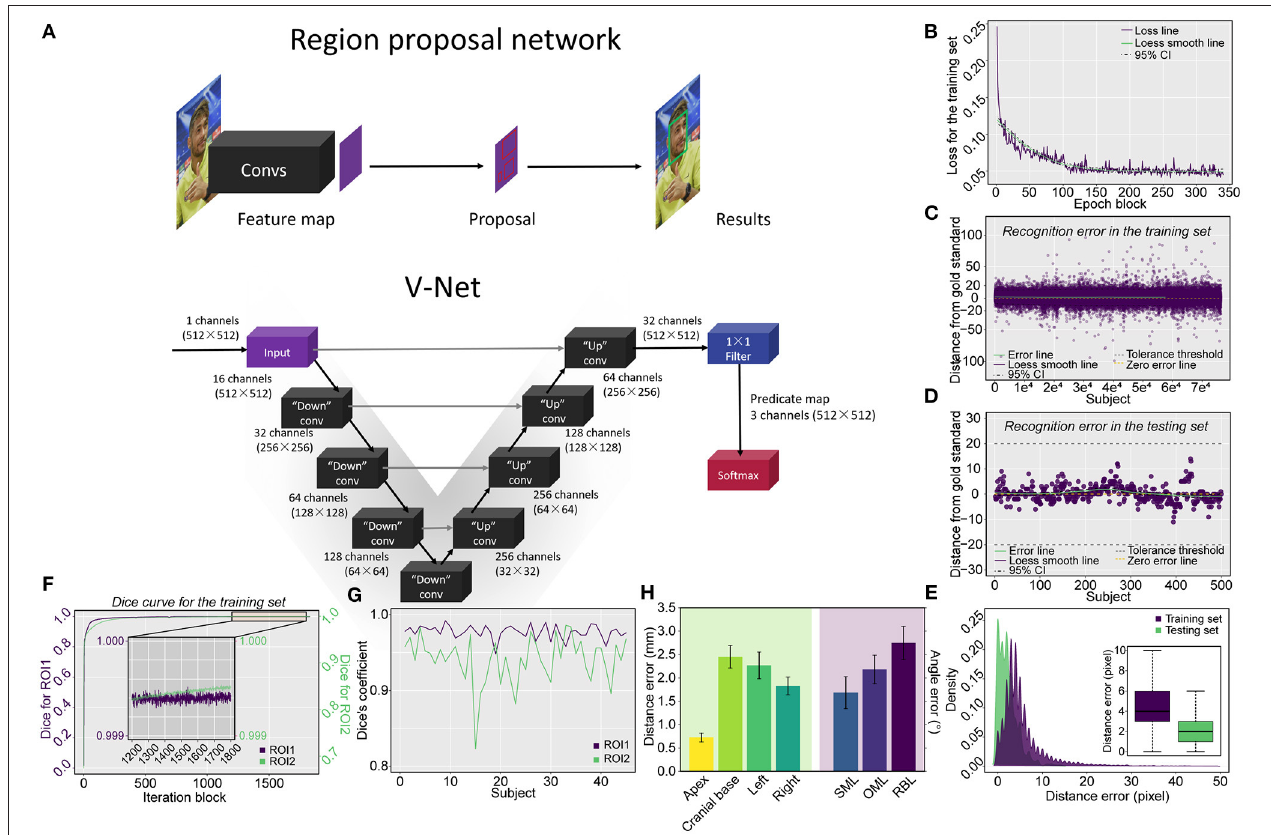
FIGURE 2 | Schematic representation of the applied network architecture, the training process of the RPN and model evaluation via the testing set, and the pulmonary segmentation Dice coefficient measurement in both the training and testing procedures. (A) The networks include both the RPN used for locating the starting position for the scan and the V-Net used for cranial segmentation. (B) The loss curve of the training process converges and trends to zero after 340 epoch blocks (340 × 500 = 170,000 epochs). The errors derived from the training and testing procedures are shown in (C,D) , respectively, in which (E) the vast majority of errors were located in the tolerance interval of ± 20mm for the training procedure and all errors were tolerable in the verifying procedure. The Dice coefficient measurement for cranial segmentation in both the training and testing procedures is shown in (F,G) . (F) With the increase in epoch blocks (1 iteration block equals 231 iterations, a total of 422,499 iterations in the training set including 295 topograms), the Dice coefficient increases rapidly and approaches the peak value of 1. The Dice coefficients of ROI1 (triangular area) and ROI2 (skull) converge and approach 1 in the tail 1,200–1,800 epoch blocks of the training procedure. The exact Dice coefficient curves obtained by deploying the model on the testing set for the triangular area and skull are shown in (G) . (H) Barplot showing the boundary distance and angle error by deploying the model using the testing set. SML, supraorbitomeatal line; OML, orbitomeatal line; RBL, Reid’s baseline.